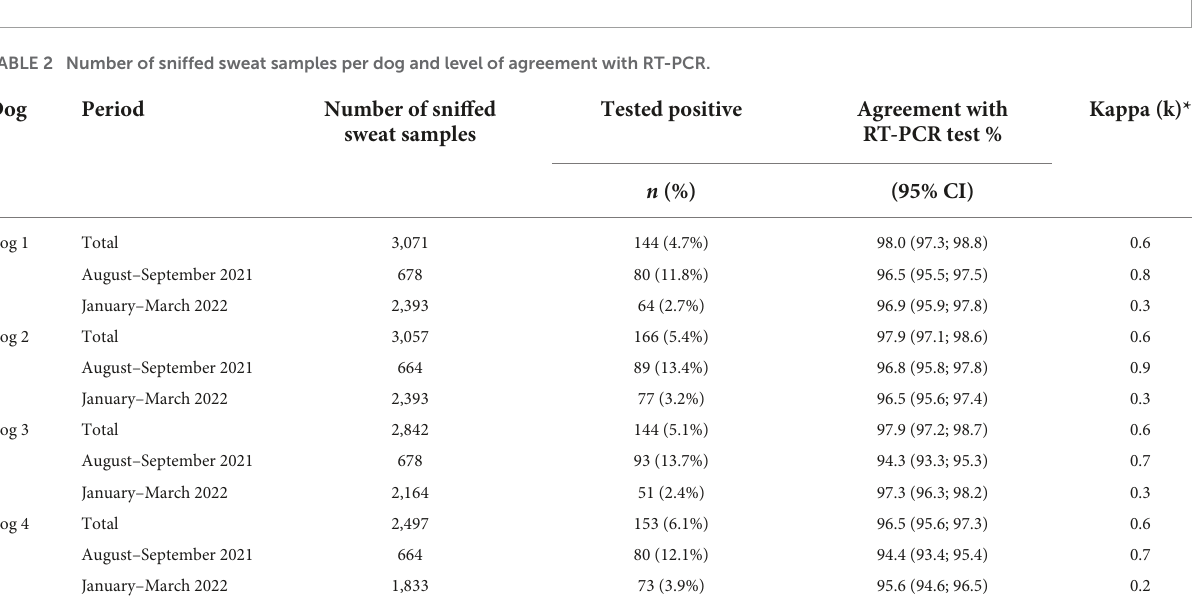
TABLE 2 Number of sniffed sweat samples per dog and level of agreement with RT-PCR.